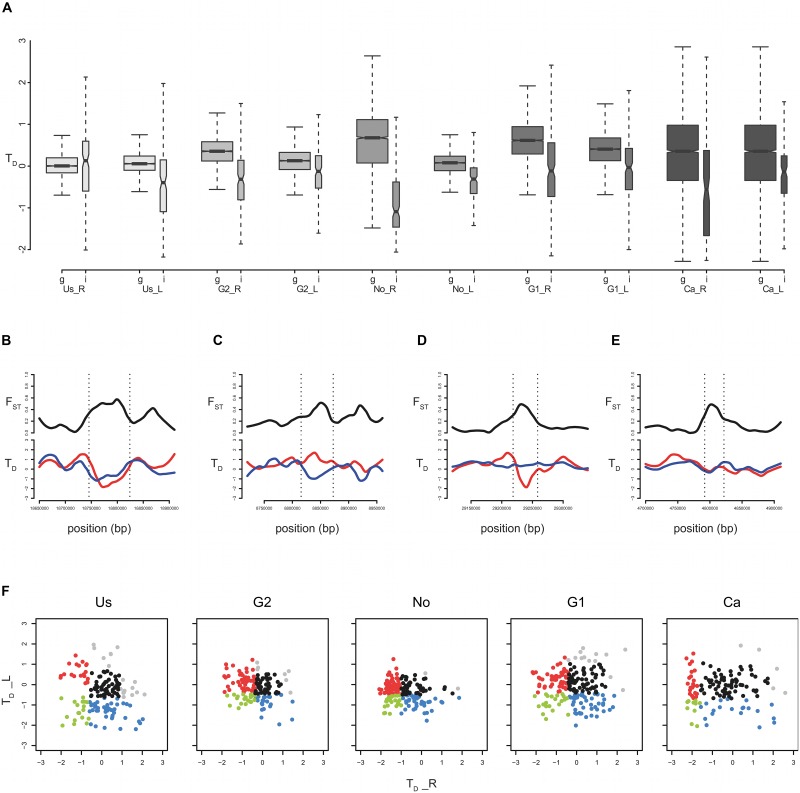
Characterizing divergent regions of exceptional differentiation by molecular signatures of evolution.
A) Boxplot demonstrating the negative shift of Tajima’s D (TD) in divergent regions (right box) compared to the genome-wide means (100 kb windows; left box). Population pairs are ordered by increasing genomic divergence (left to right), with rivers plotted first followed by lakes. In all populations except for Us_R (Mann-Whitney, W = 290246, P = 0.7942) TD in divergent regions is significantly different from the genome-wide mean (the least extreme being in G2_L, W = 198559, P < 10-8; Bonferroni correction for family error rate lowered significance level: alpha/m = 0.005). B-E) Representative molecular signatures of evolution used to categorize regions. Smoothed averages across 10 kb windows are given for FST (black) and TD in the river population (red) and the lake population (blue). B) Low TD values in both the lake and the river (below the 5% quantile of the genome-wide distribution) were interpreted as evidence for background selection (selection against new mutations in both populations causing a divergence signal by reducing diversity in both populations). C) Low TD values in only the parapatric lake population was interpreted as indications for positive selection (local adaptation) as the potential cause for a local reduction of effective population size. D) The same as (C) except for low TD values in only the parapatric river populations. E) Regions that fall into the middle of the TD distribution (excluding the 5% most extreme values of both tails) showing neutral patterns were interpreted as being shaped by a reduction of gene flow. F) For each divergent region, Tajima’s D (TD) values are plotted for the lake (y-axis) and river (x-axis) of each population pair. Categories as given above and in Table 1 are represented by colors: red dots represent “adaptation river”, blue “adaptation lake”, green “background selection”, and black “reduced gene flow”. Please refer to Table 1 for the exact number of divergent regions per category and population pair.